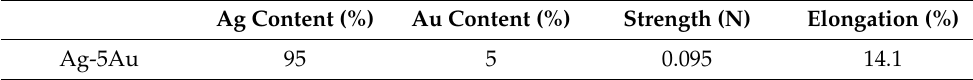
Table 1. Alloy wire element content and mechanical properties table.